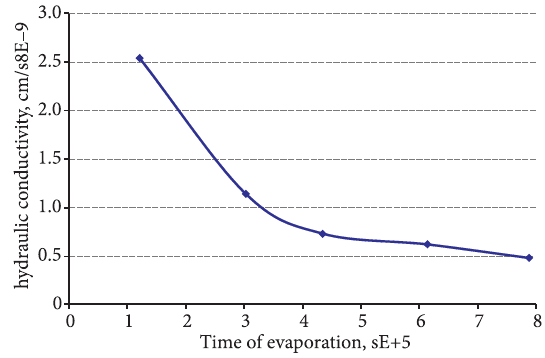
Fig. 2. Dependence of water evaporation time from water surface level of piezometer on hydraulic conductivity (assumed)